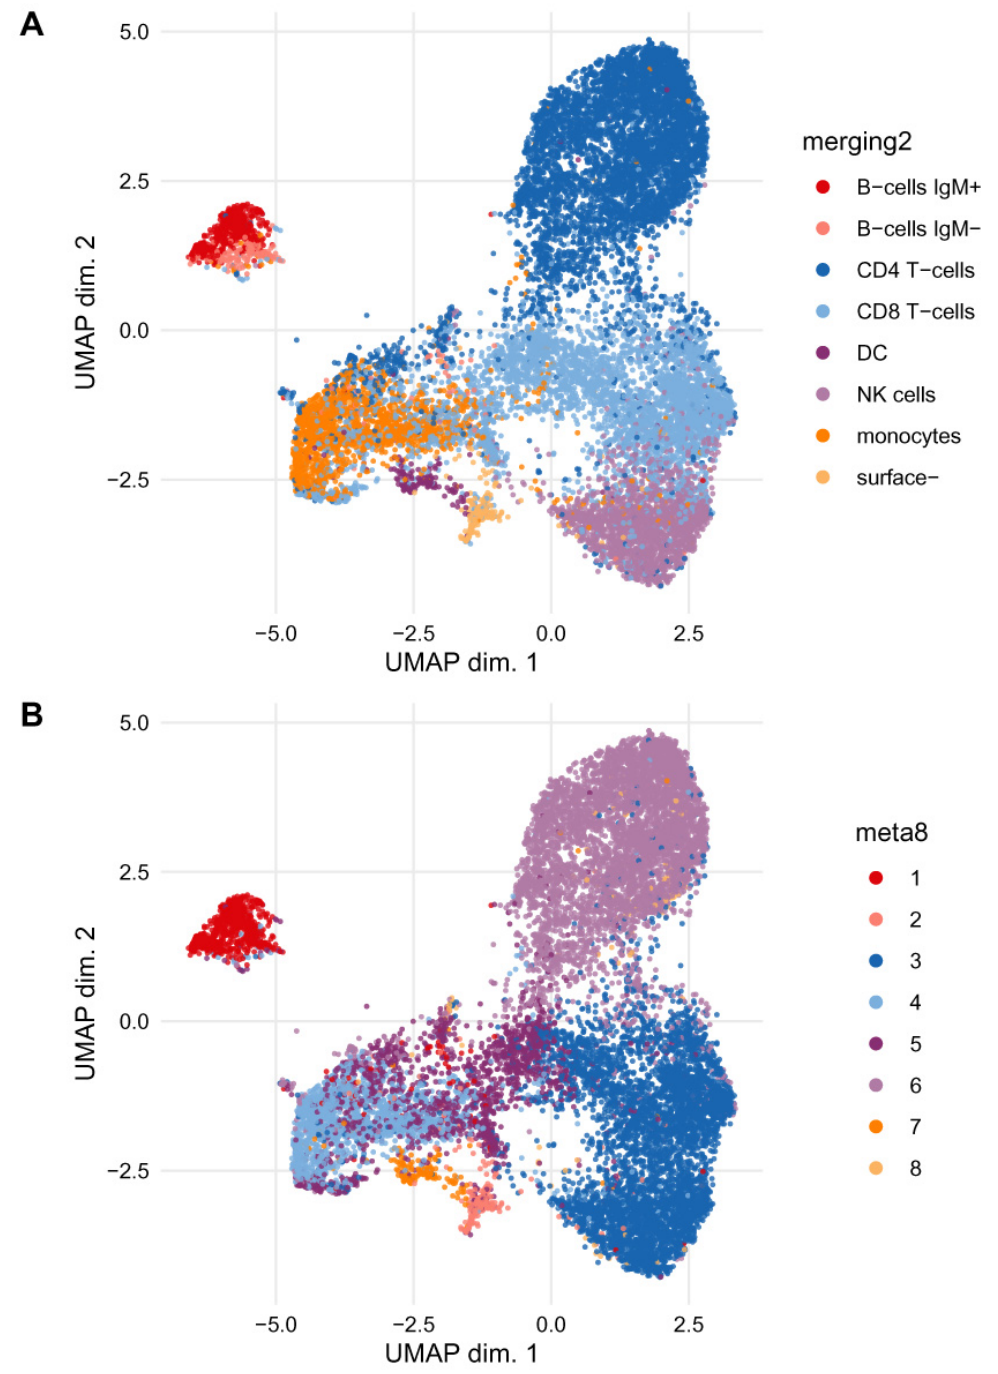
Figure 19. UMAP plot with cells colored according to ( A ) the expert merging of 12 metaclusters obtained with FlowSOM into 8 PBMC populations; and ( B ) the 8 automatically detected with FlowSOM